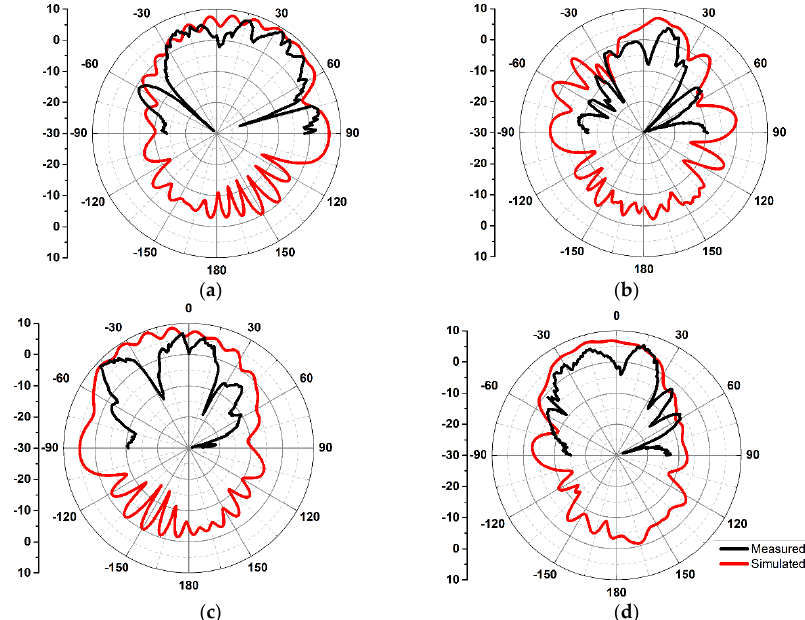
Figure 12. Simulated and Measured 2D Radiation patterns at 28 GHz for: ( a ) 5G Ant3 in the XZ plane; ( b ) 5G Ant3 in the YZ plane; ( c ) 5G Ant6 in the XZ plane; ( d ) 5G Ant6 in the YZ plane.